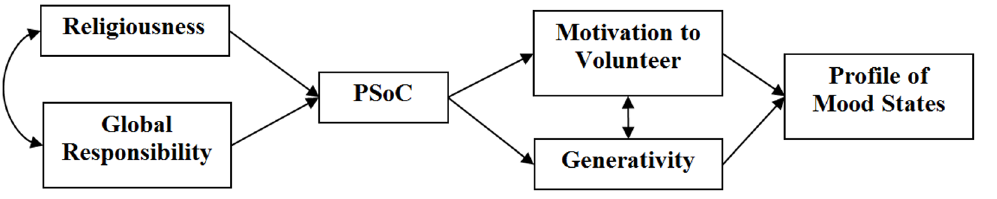
Figure 1. A conceptual model depicting the impact of religiousness and global responsibility on the profile of mood states through the mediation of psychological sense of community (Psoc), motivation to volunteer, and